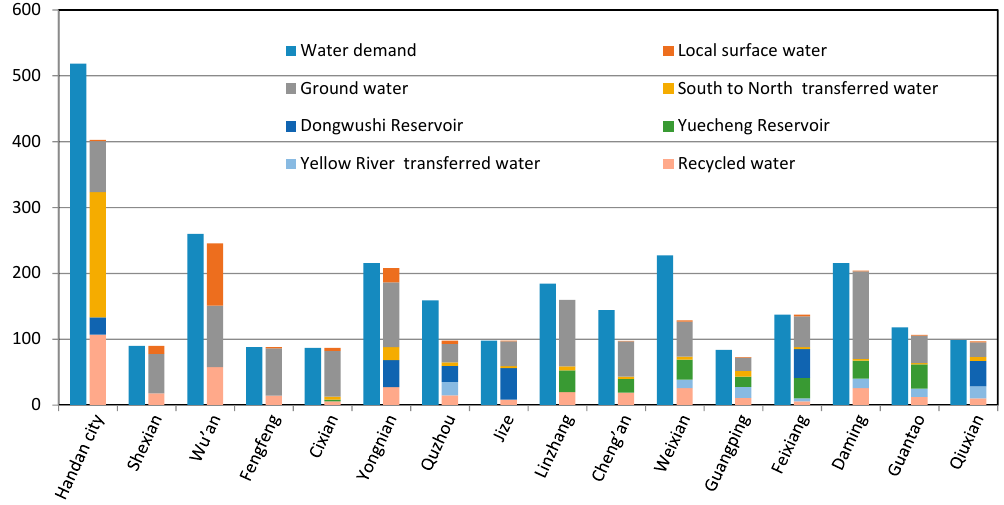
Figure 3. Optimal water resource allocation results in Handan (10 6 m 3 ).